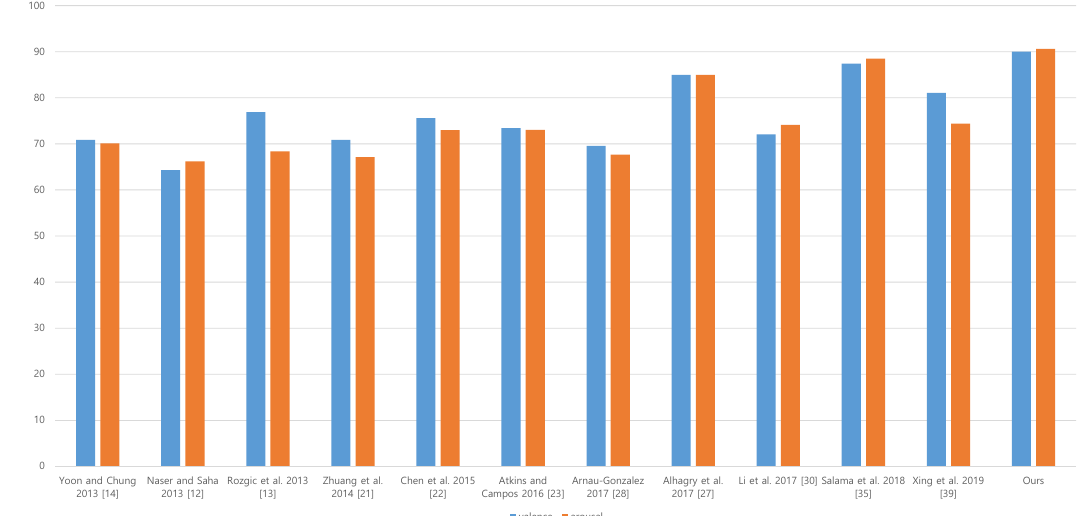
Figure 5. The comparison of our results with the results of existing models.